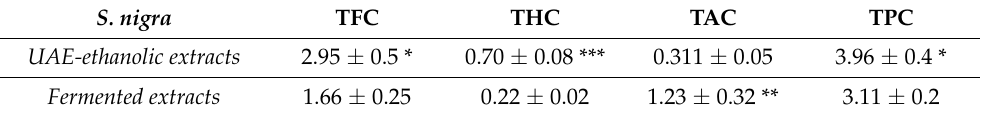
Table 2. Content of polyphenols (in mg g − 1 DW) in UAE-ethanolic and fermented extracts of elder- berry ( S. nigra ) fruits. TFC—total flavonoid content; THC—total hydroxycinnamic acid derivatives content; TAC—total anthocyanins content; TPC—total polyphenols content. S.